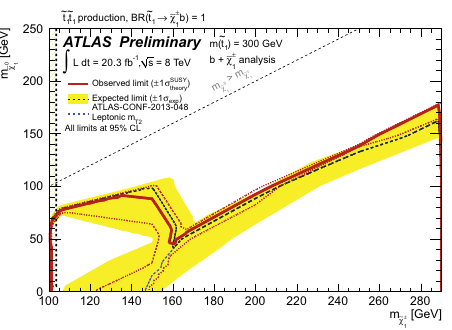
Figure 6: Exclusion limits at 95% CL from the Figure 7: t + ˜ χ 0 1 analysis: exclusion limits at 95% analysis of 20 . 3 fb − 1 of 8 TeV collision data on CL in the m (˜ t 1 ) − m (˜ χ 0 1 ) plane for the combi- the masses of the chargino and the lightest neu- nation of the same flavour and di ff erent flavour tralino, for a stop with a mass of 300 GeV and channel from the analysis of 20 . 3 fb − 1 of 8 TeV ± = 1. [6] assuming BR(˜ t 1 → b + ˜ χ collision data. 1 )